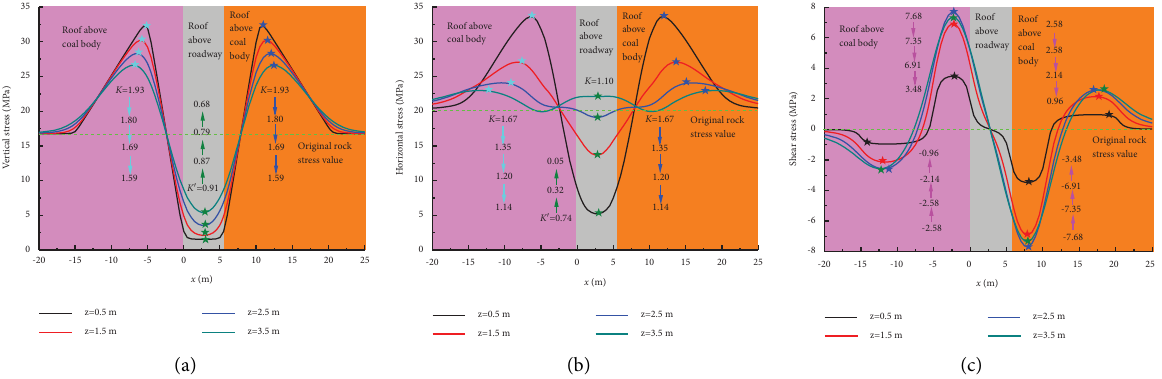
Figure 7: Roof stress distribution curve: (a) vertical stress; (b) horizontal stress; (c) shear